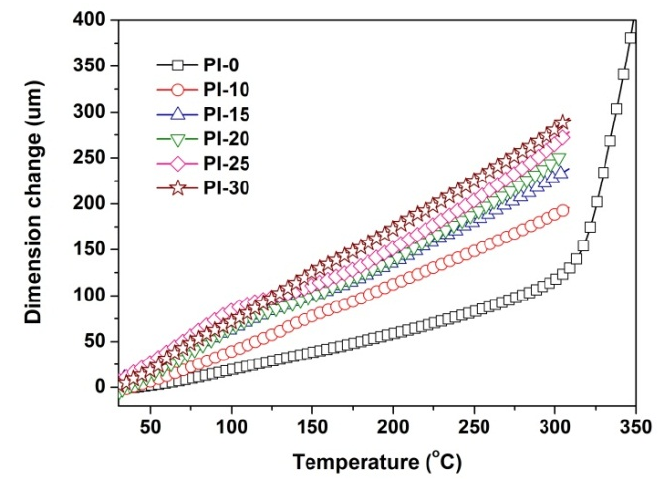
Figure 9. TMA curves of POSS-PI films.